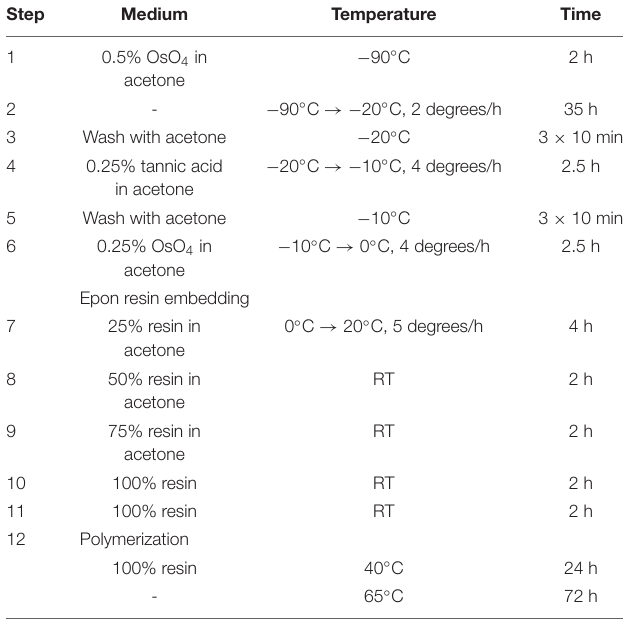
TABLE 2 | The protocol of freeze-substitution and resin embedding.